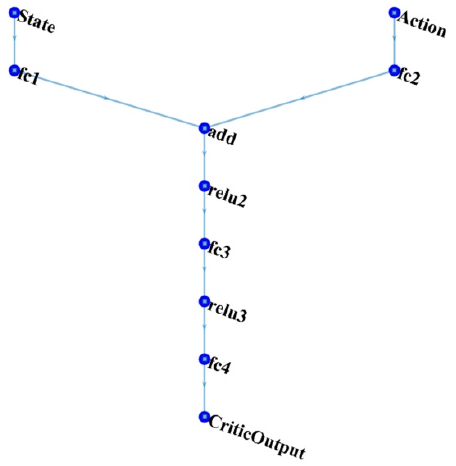
Figure 7. The graphic representation of the created DNN.